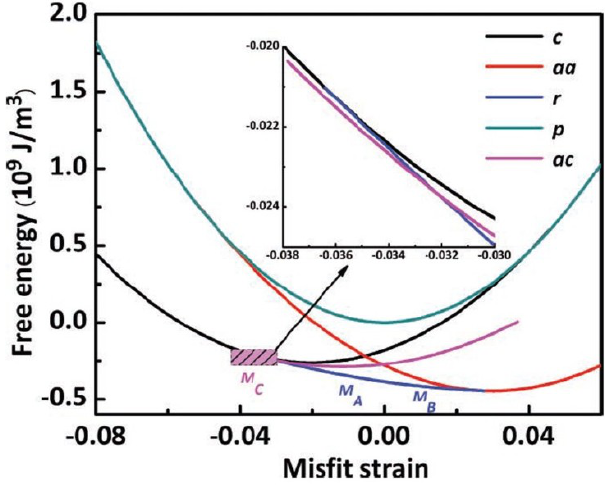
transition. (Reprinted with permission from [30]. Copyright 2011 WILEY-VCH)